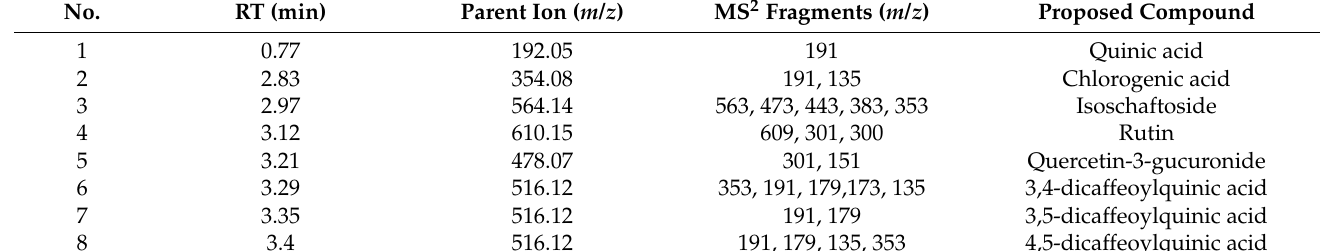
Table 1. The identified compounds in the AASC.